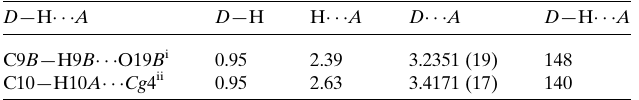
Table 1 Hydrogen-bond geometry (A˚ , (cid:3) ). Cg 4 is the centroid of the C8 B –C13 B ring.